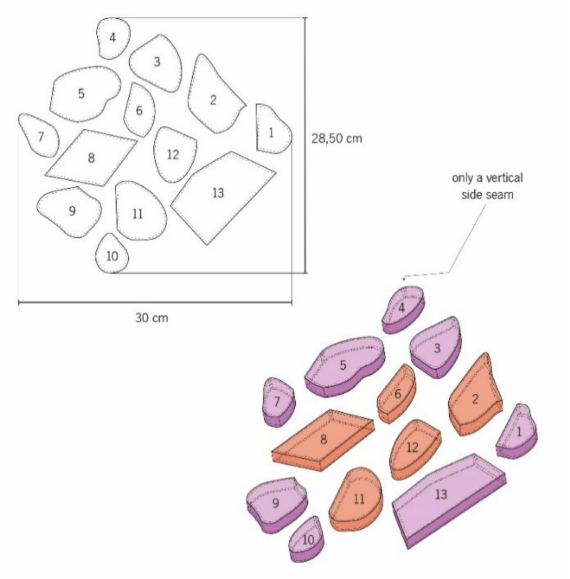
Figure 5. Technical drawing of the embossed structures of the pattern module